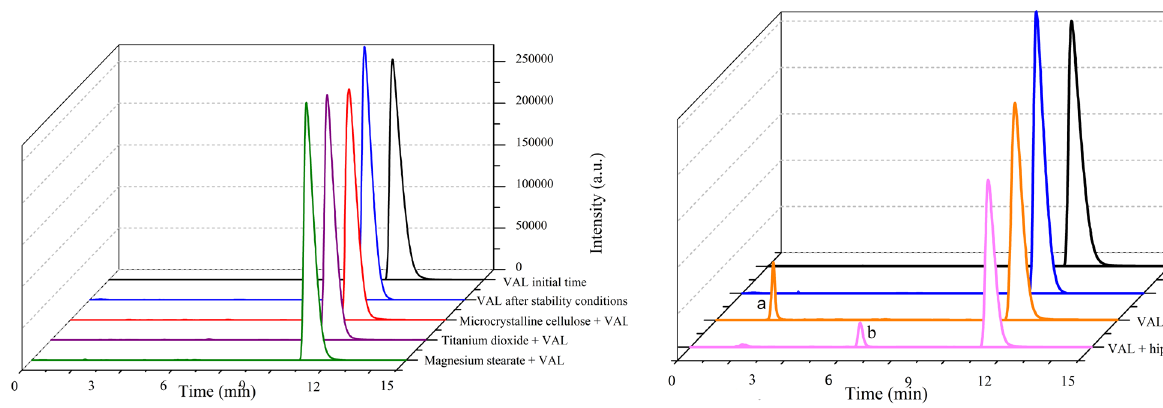
FIGURE 5 - HPLC chromatogram of VAL before storage and of binary mixtures with microcrystalline cellulose, titanium dioxide, and magnesium stearate after storage.